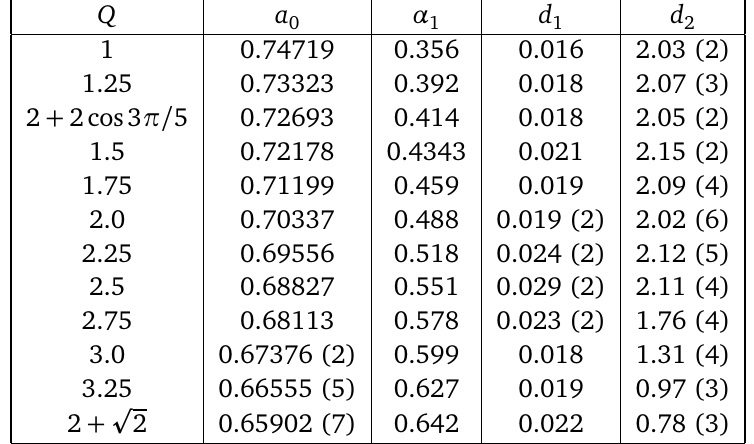
Table A.3: Parameters of the ansatz (140) for the two-point connectivity, determined by fitting Monte-Carlo